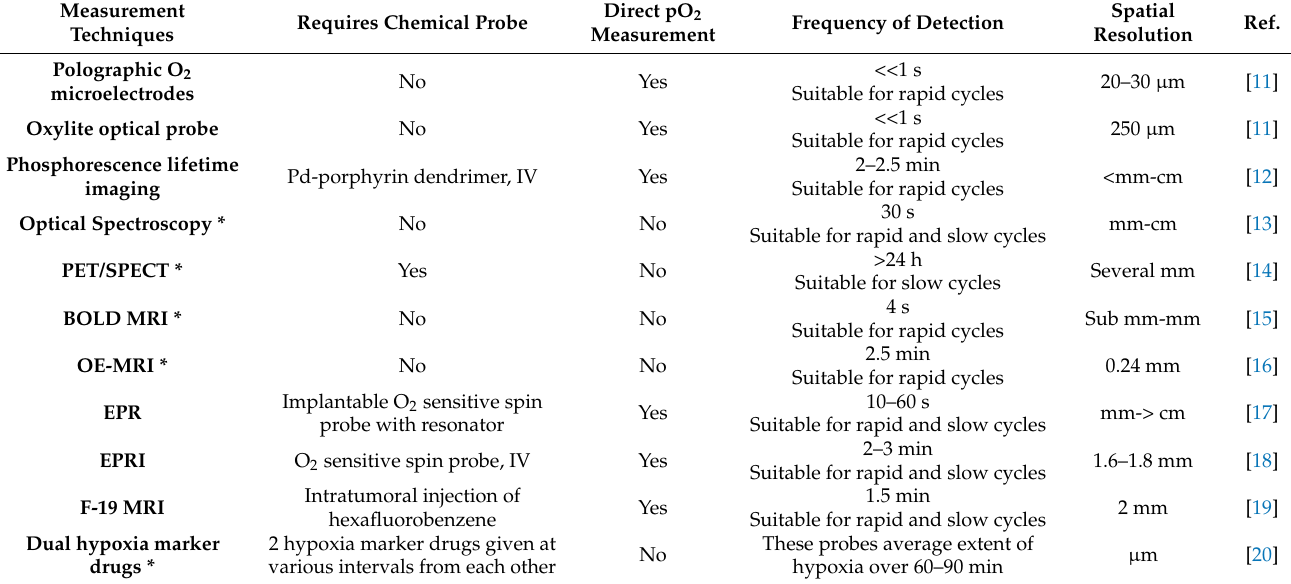
Table 1. Summary of the cyclic hypoxia measurement techniques. PET = positron emission tomography; SPECT = single-photon emission computed tomography; BOLD MRI = blood oxygen level dependent MRI, measured by R 2 *, OE-MRI measures R1, which is sensitive to [O 2 ] in tissue; EPR = electron paramagnetic resonance; EPRI = electron paramagnetic resonance imaging; * = methods that have been used to measure hypoxia in human tumors and are amenable to measuring cyclic hypoxia. Rapid cycles = cycles occurring over 1–2 h observation. Slow cycles = cycles occurring over many hours to days. Measurement